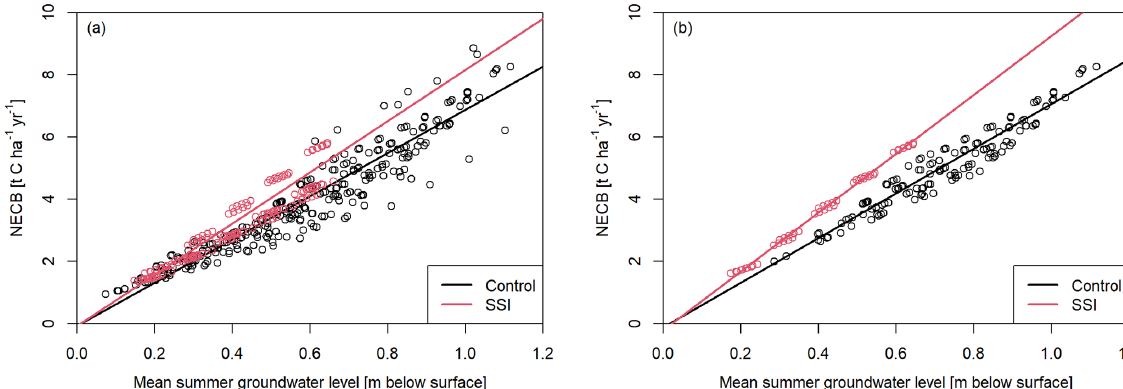
Figure 10. Mean modelled summer groundwater level and NECB for simulations with and without SSI, for (a) all simulations and (b) simu- lations of 2018 and 2020 consisting of severe summer drought. Slope and intercept of plotted linear regression models are shown in Table 3. Table 3. Estimated linear relation characteristics with standard errors to approximate NECB ( t Cha − 1 yr − 1 ) by using water table depth relations plotted in Figs. 10 and 11. Standard errors include standard error estimates of Eq. (5). Model scenarios Mean water table period (metres below